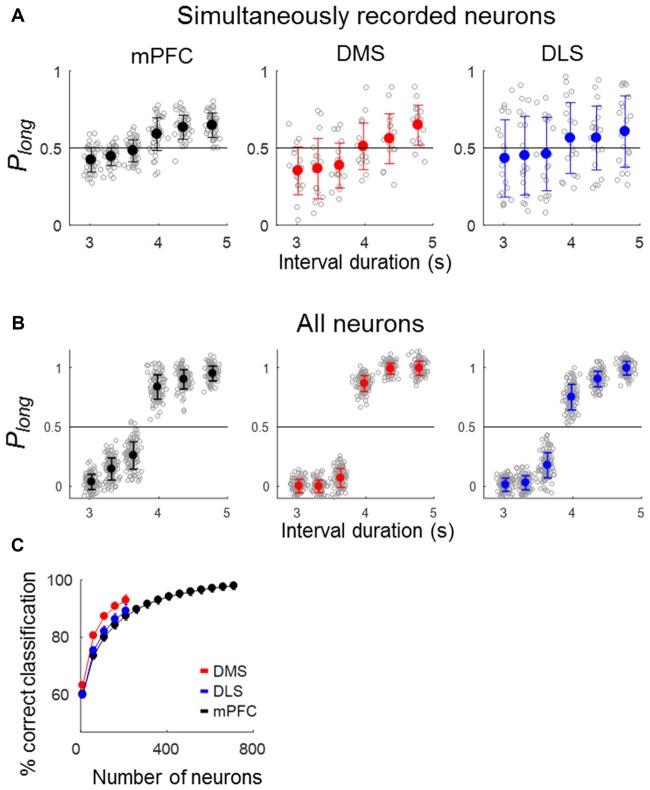
Neural classification of sample-interval length. Sample intervals were classified as short or long based on neuronal ensemble activity during the last 500 ms of each sample interval using a discriminant analysis. Only correct trials were included in the analysis. (A) Classification of sample-interval length based on simultaneously recorded units. Neural classification was performed using six neurons that were selected randomly from each simultaneously recorded ensemble, and this was repeated 100 times. Each gray circle denotes the outcome of 100 classifications obtained from each ensemble. Circles with saturated colors (black, blue and red) denote their means. Plong, the fraction of long-sample classification. (B) Classification of sample-interval length based on all recorded units pooled across sessions (ensemble size = 200 neurons). The same as in (A) except that all recorded neurons were included in the analysis. (C) Results of a neuron dropping analysis applied to all recorded units. Shown are outcomes of neural classification as a function of ensemble size in steps of 50 neurons starting from an ensemble size of 10 neurons. A given number of units were selected randomly for each ensemble size, and this was repeated 100 times. Error bars, SD.